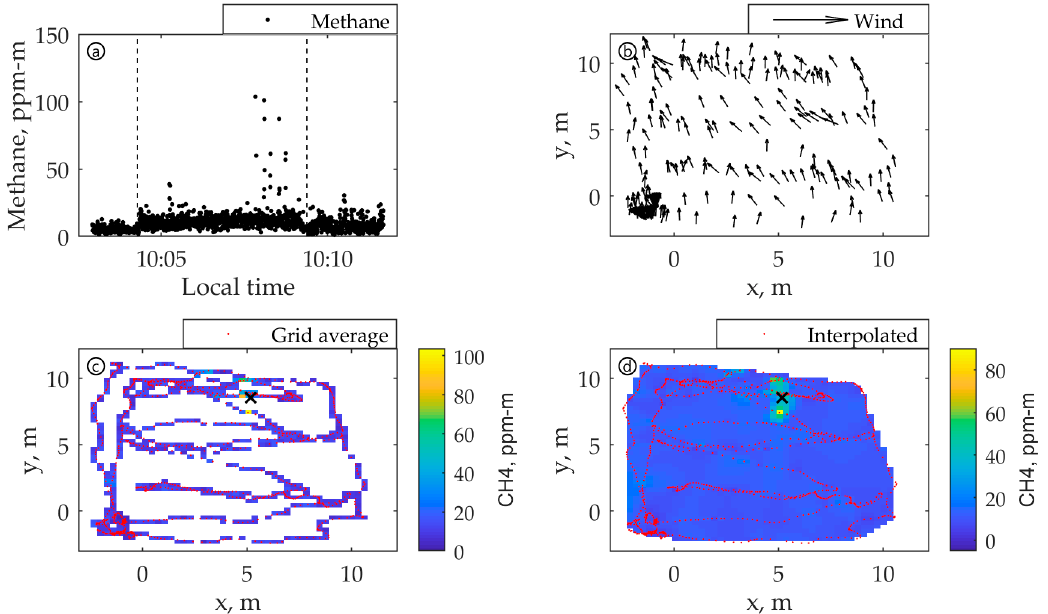
Figure 1. Sample data during a controlled release: ( a ) methane time series; ( b ) wind vectors shown based on unmanned aerial system (UAS) location (downsampled for clarity); ( c ) methane concentrations averaged on a regular grid; ( d ) interpolated methane data. The black ‘x’ indicates the actual leak position. Vertical dashed lines in ( a ) represent takeoff and landing. Red lines indicate the Remote Methane Leak Detector (RMLD)-unmanned aerial vehicle (UAV) flight tracks.